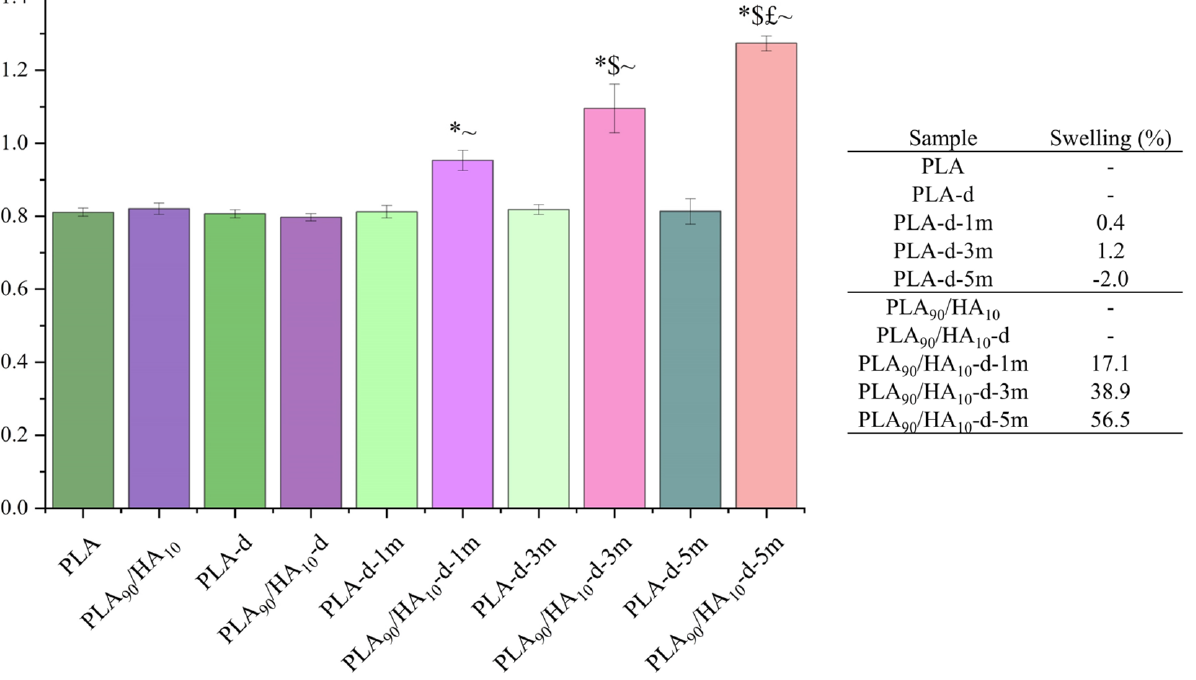
Figure 9 . Volume ( left ) and related swelling ( right ) of the samples before/after conditioning in cell culture medium at 37 °C during up to 5 months. Mann–Whitney test p < 0.05; for PLA or PLA 90 /HA 10 : * vs. -d, $ vs. 1 m, £ vs. 3 m; for PLA90/HA10: ~ vs. PLA.